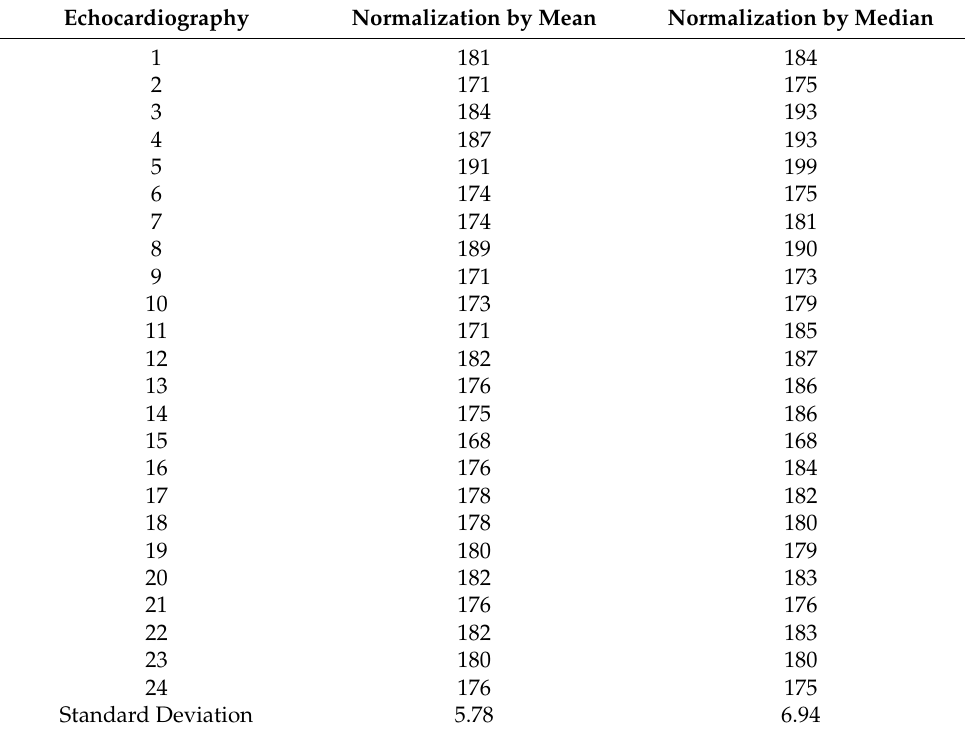
Table 1. Descriptive statistics, where Echocardiography 1 to 9 belongs to patient 1, 10 to 16 belongs to patient 2, and 17 to 24 belongs to patient